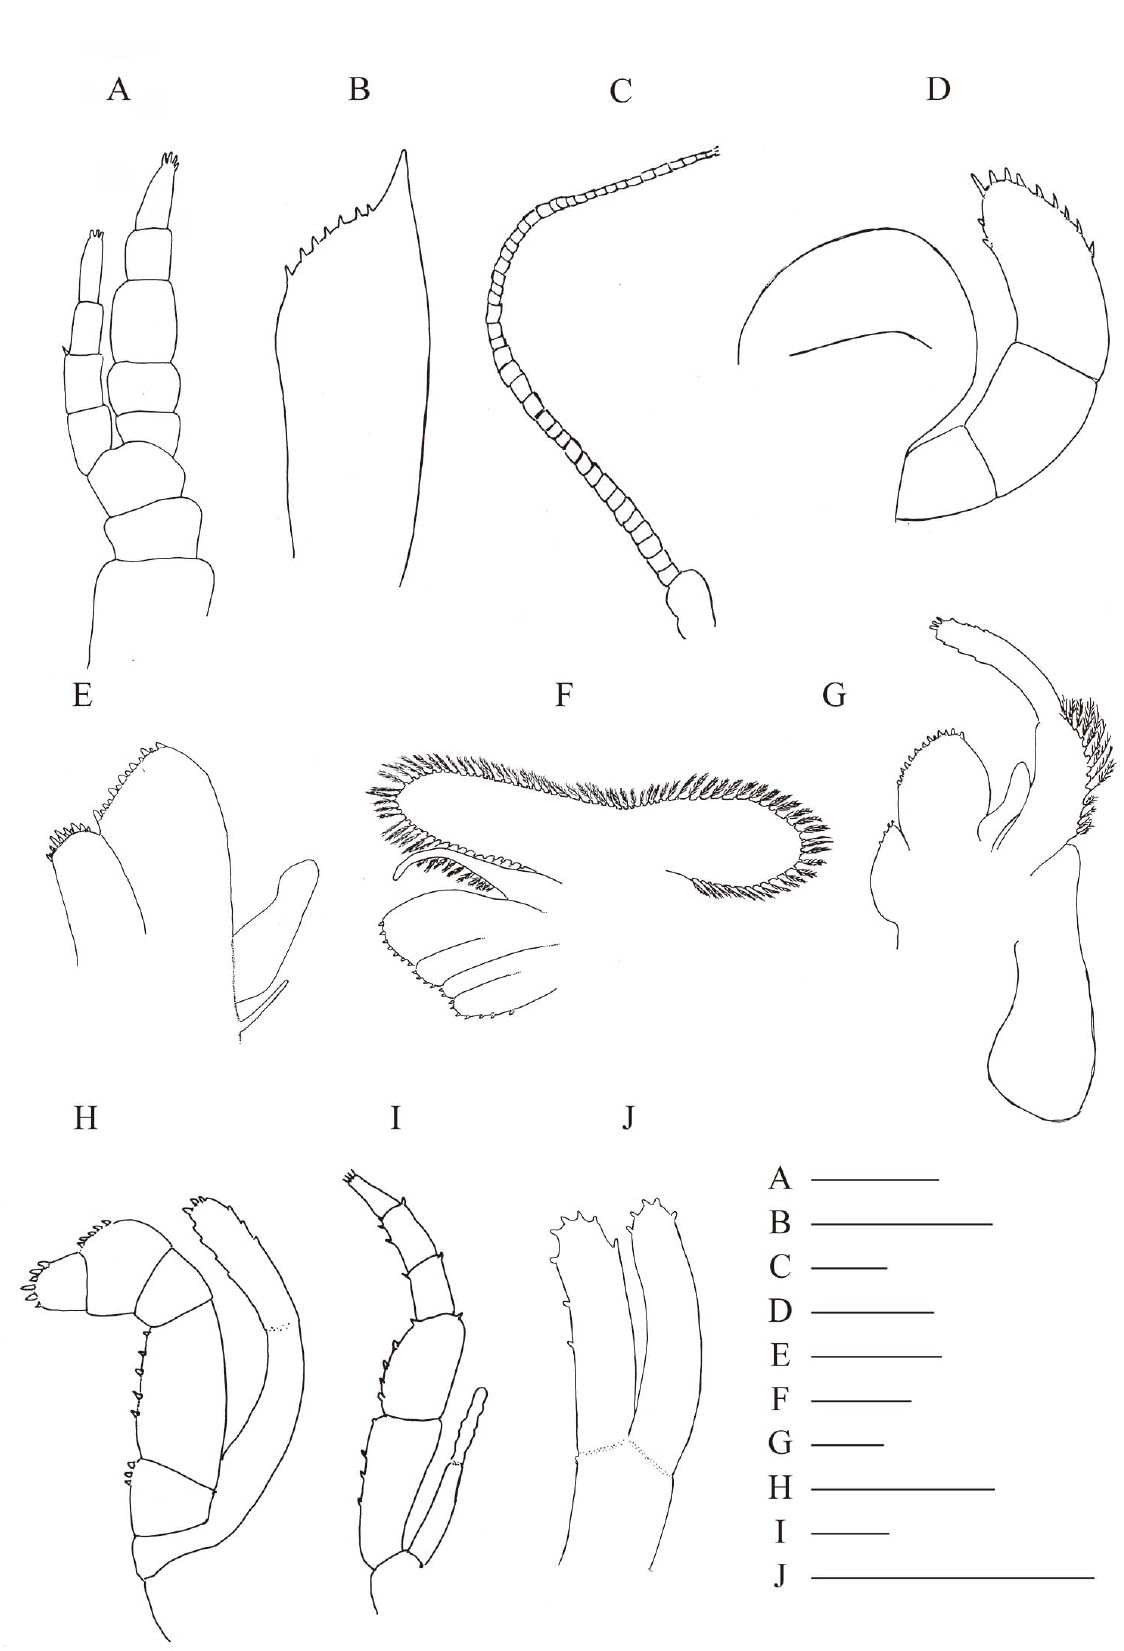
Figure 14. Juvenile Stage I of Cambaroides japonicus . ( A ) Antenna 1, dorsal view; ( B ) antennal scale, dorsal view; ( C ) antenna 2, dorsal view; ( D ) mandible, view of inside of mouth; ( E ) maxilla 1, oral view; ( F ) maxilla 2, oral view; ( G ) first maxilliped, oral view; ( H ) second maxilliped, oral view; ( I ) third maxilliped, oral view, ( J ) pleopod. Scale bars: 0.25